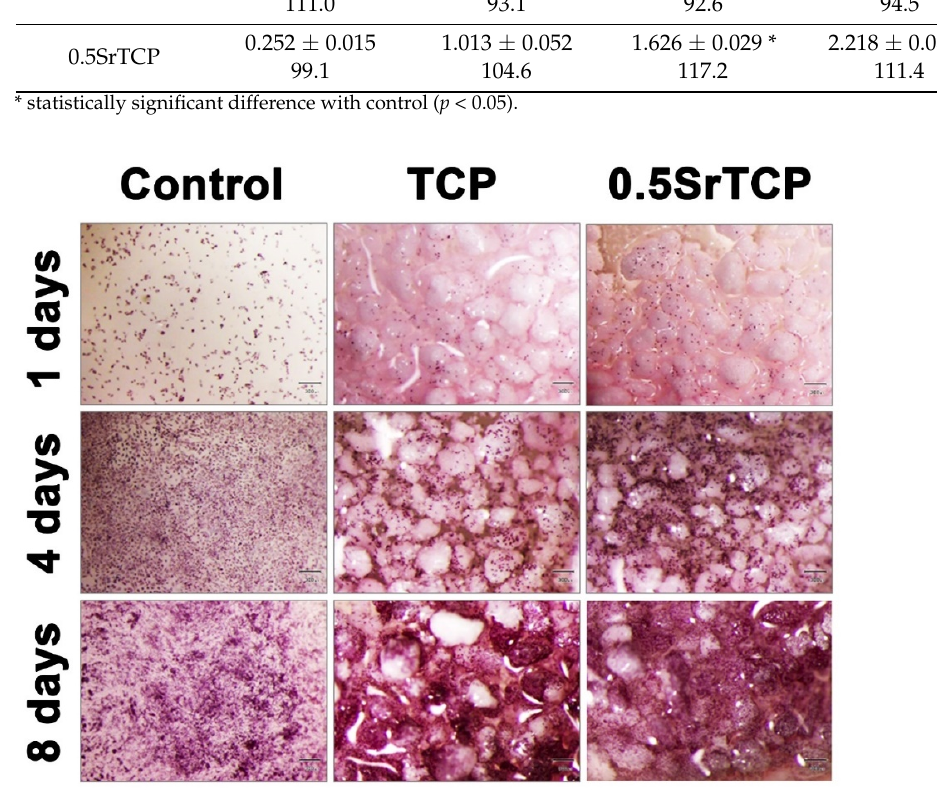
Table 3. Optical density values of the formazan solution (MTT test) and the percentage of viable cells (PVC) during the growth of MG-63 cells on TCP and 0.5SrTCP ceramic samples. Samples